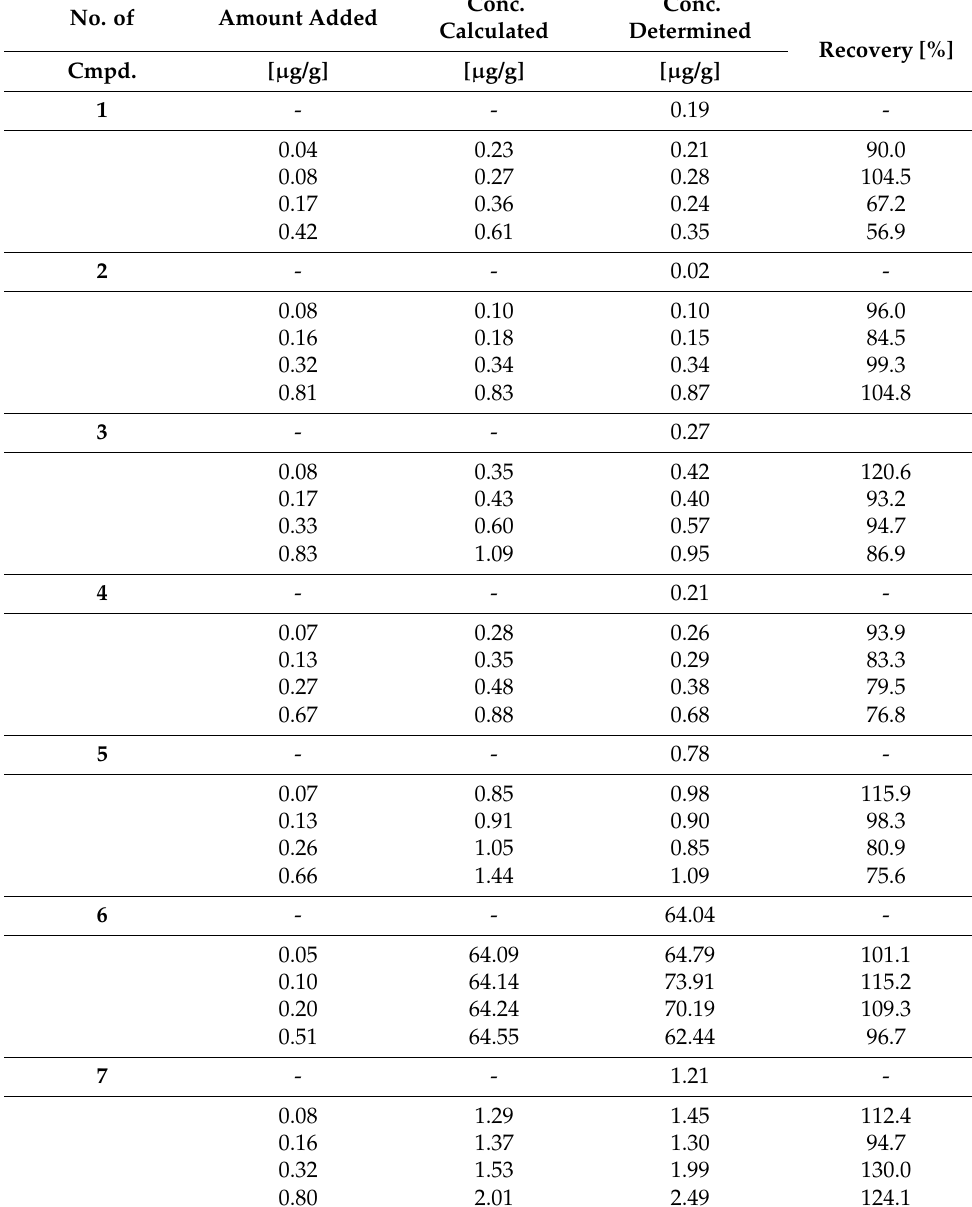
Table 2. Determination of the recovery rates for the quantitative analysis of bitter compounds 1 – 14 in carrots. No. of Amount Added